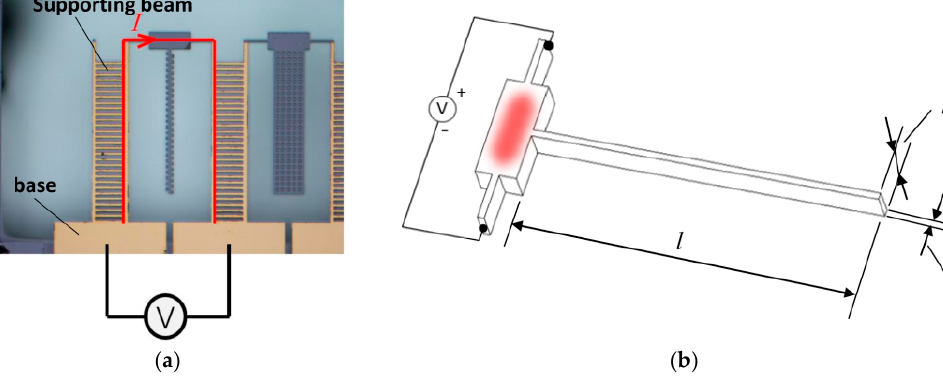
Figure 2. Working principle of the experiment: ( a ) Diagram of loading voltage; ( b ) schematic diagram of device heating.